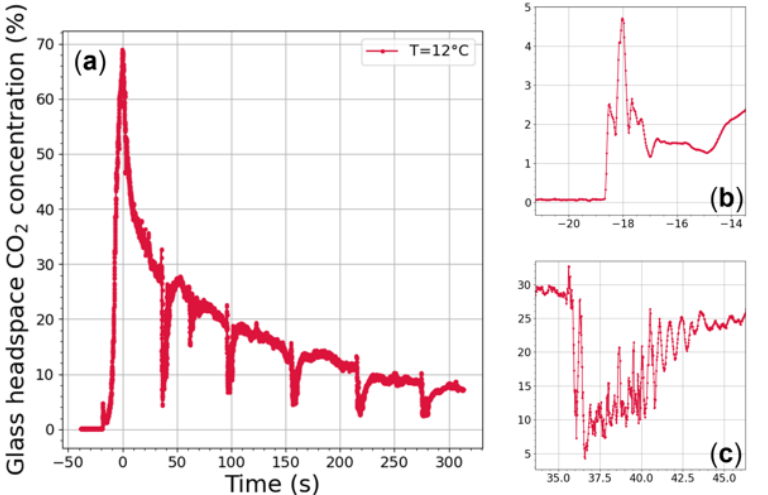
Figure 6. Monitoring of gas-phase CO 2 concentrations (in %) conducted 5 mm below the edge of the INAO glass filled with 100 mL of champagne (at 12 °C). During the first 5 min following the end of the pouring step (marked as t = 0 s), five 5 s consecutive rotations (at 225 rpm with a radius of 4.5 mm) were triggered by the orbital shaker, with a 1 min time interval between swirling periods ( a ). Just before champagne falls in the glass, a zoom of the data recording shows a little peak of gas-phase CO 2 with a concentration close to 4–5% ( b ). Another zoom highlights the quick variations to CO 2 concentration during the 5 s swirling period and the several seconds following ( c ).